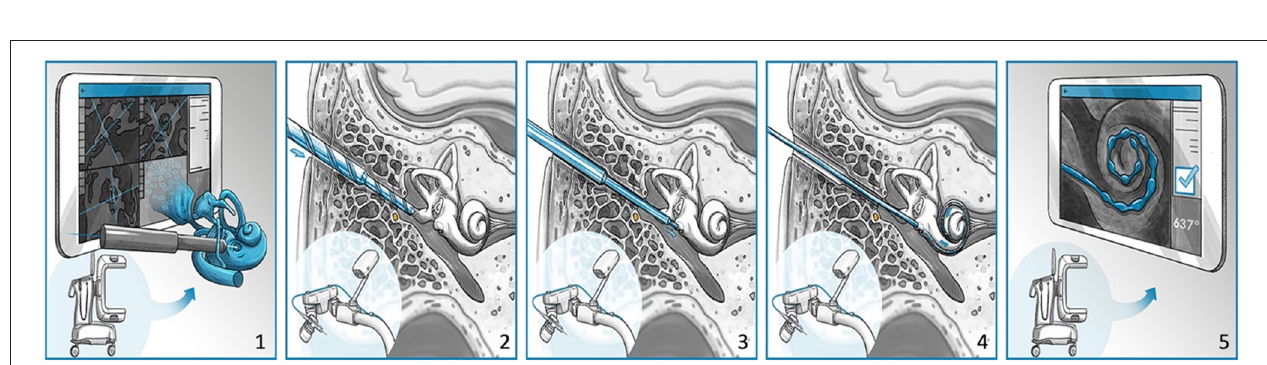
FIGURE 2 | The HEARO procedure for cochlear implantation surgery. (1) Scanning and planning, (2) performing middle ear access with cutting bur, (3) performing inner ear access with diamond bur, (4) placement of array through a removable insertion tube, and (5) postoperative scanning and quality analysis.